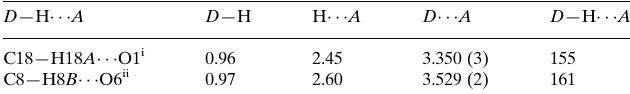
Hydrogen-bond geometry (A˚ , (cid:3)